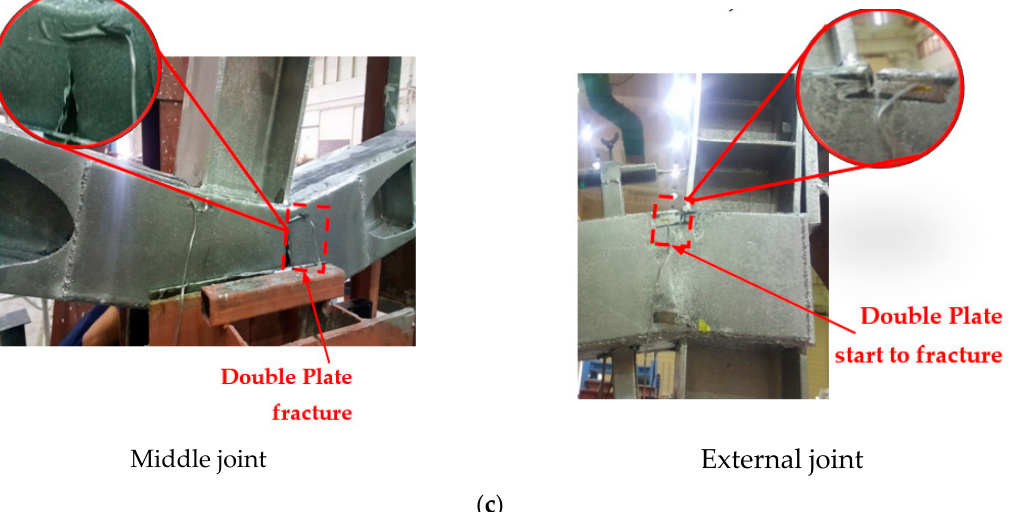
Figure 4. Failure-mode for experimental testes (external and middle joint): ( a ) J-S-C joint; ( b ) J-M-C joint; ( c ) J-S-S-EX joint [6,29].